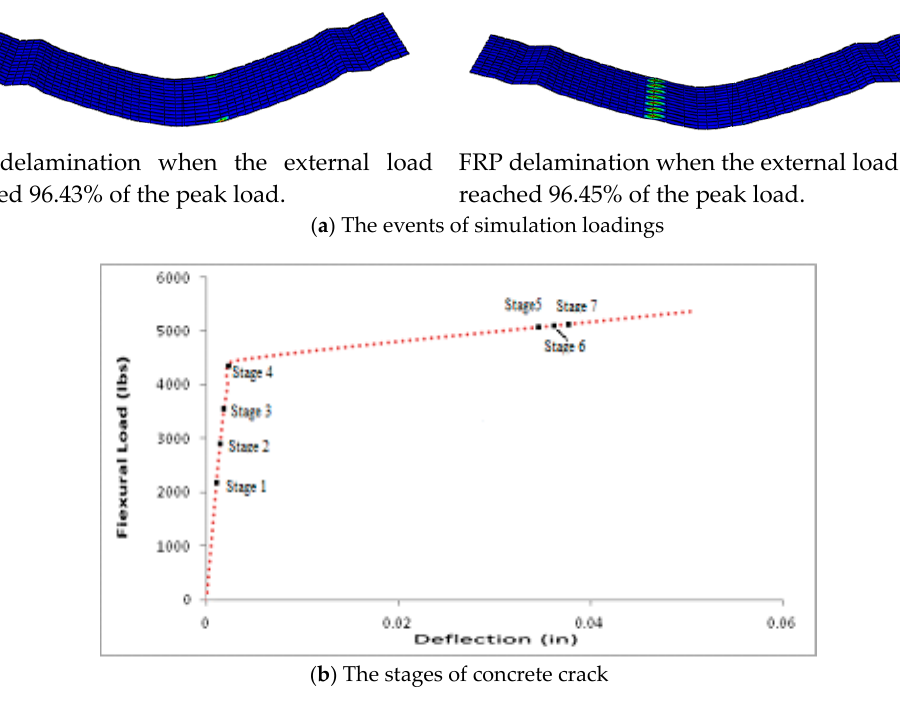
Figure 9. Numerical flexural response of FRP strengthened concrete beams and the stages of concrete crack at 180 ◦ C. ( a ) The events of simulation loadings; ( b ) The stages of concrete crack.